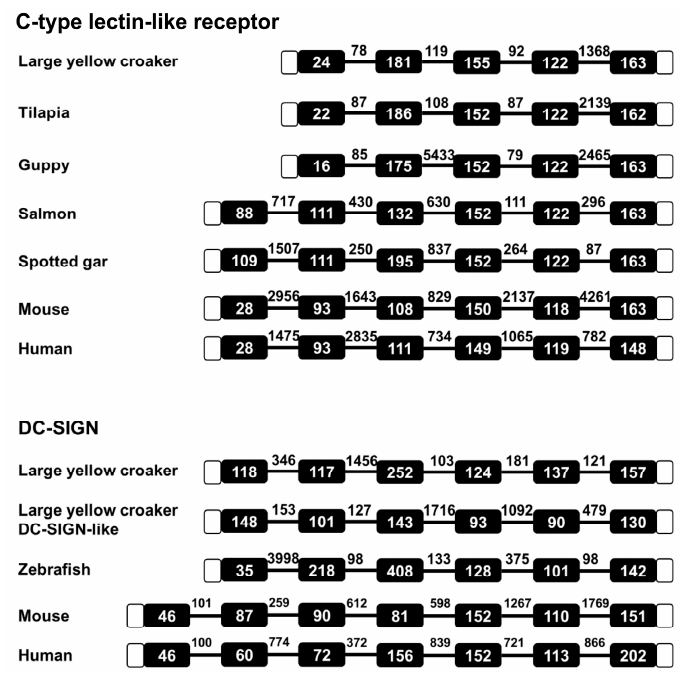
Figure 3. Genomic structure analyses of CTLR and DC-SIGN genes from fish and mammals. Exons are represented by closed boxes, and introns are represented by horizontal lines. Open boxes indicate UTR regions. The nucleotide length is shown in boxes and above lines. The genomic DNA sequences (and their accession numbers) are taken from GenBank database: CTLR: large yellow croaker, KQ041363 (EH28_17225); tilapia, NC_022209; guppy, NC_024346; salmon A, NM_001123579; spotted gar, NC_023204; mouse, NC_000072.6; human, AC092746.9. DC-SIGN: large yellow croaker, KQ041008;